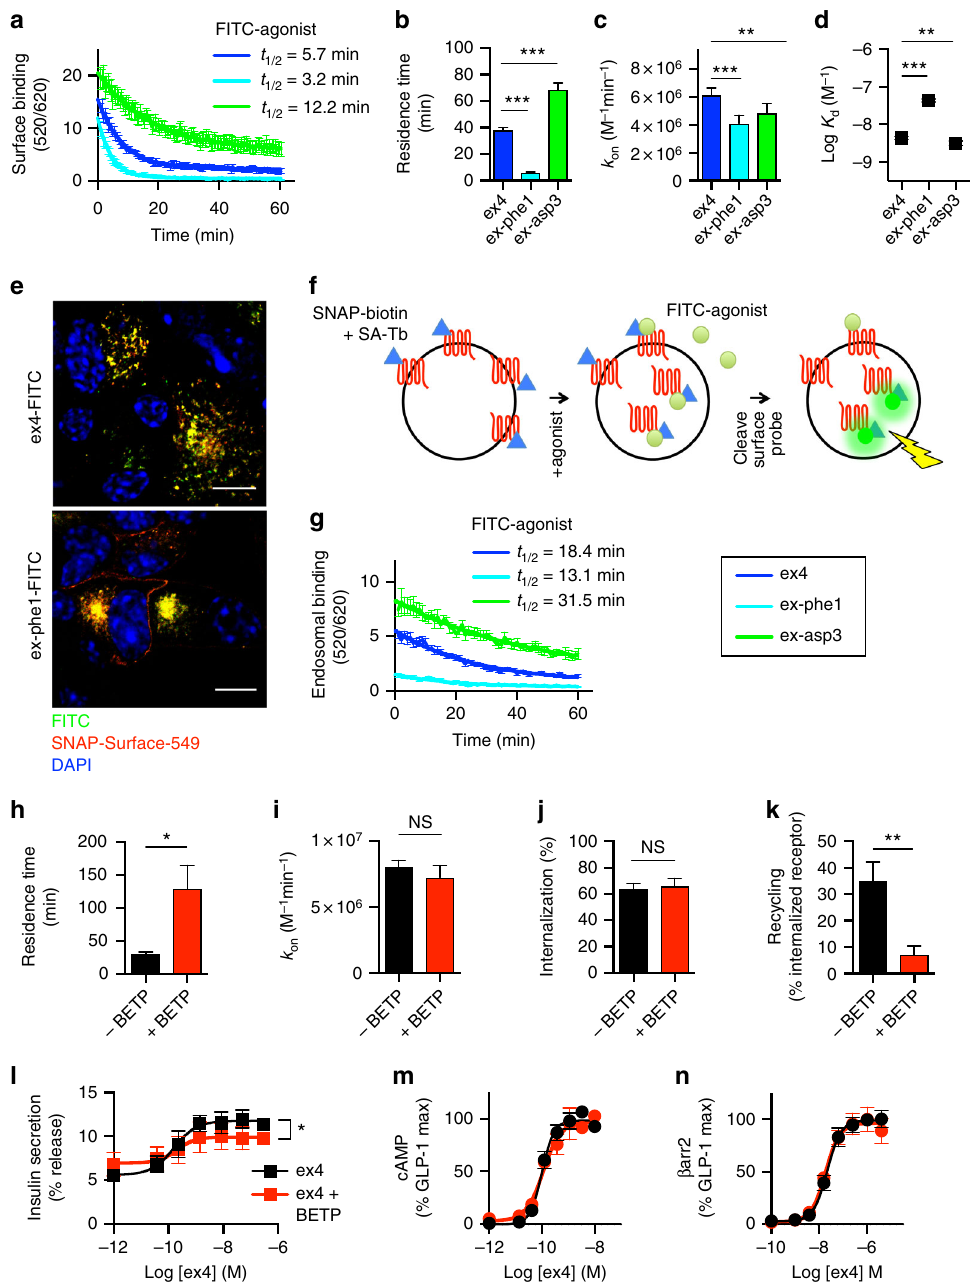
Fig. 5 Binding kinetics in fl uence GLP-1R recycling. a Dissociation curve indicating FRET between FITC-agonist complexed with surface SNAP-GLP-1R, after inhibition of internalization, using NaN 3 and 2-deoxyglucose 9 (Supplementary Fig. 9), 30 min agonist exposure, washout, and exendin(9-39) blockade, n = exendin-4-FITC, with internalization inhibitors as above, and calculated using competitive kinetic method 42 , n = 5, one-way randomized block ANOVA with Dunnett ’ s test vs. exendin-4. e Confocal fl uorescence indicating co-localization of exendin-4-FITC or exendin-phe1-FITC with SNAP-GLP-1R (labeled with SNAP-Surface-549) after 60 min agonist exposure in MIN6B1-SNAP-GLP-1R cells, representative images from n = 2 experiments; scale bars, 8 μ m. Individual red and green channels shown in Supplementary Fig. 12. f Schematic illustrating endosomal binding protocol. SA-Tb streptavidin-terbium cryptate. g Real-time FRET measurement of FITC-agonist complexed with internalized SNAP-GLP-1R after 30 min agonist exposure, washout, exendin (9-39) blockade, and cleavage of SNAP-biotin from surface SNAP-GLP-1R with MesNa, n = 5. Exendin-4 h residence time and i association rate constant ± 10 μ M BETP, measured by TR-FRET in competition with exendin-4-FITC, n = 4, paired t -test. Exendin-4-induced j internalization (30 min), and k recycling (60 min) ± 3 μ M BETP, n = 4, paired t -test. l Prolonged insulin secretion with exendin-4 ± 3 µ M BETP in INS-1 832/3 cells, 16 h, n = 5, paired t -test for E max assessed by four-parameter fi t. Exendin-4 m cAMP, and n β -arrestin-2 responses, in PathHunter CHO-GLP-1R cells ± 3 μ M BETP, n = 3. Agonists applied at 100 nM, except where indicated, and performed in CHO-SNAP-GLP-1R cells, except where indicated. * p < 0.05, *** p < 0.01, by statistical test indicated above. Error bars indicate